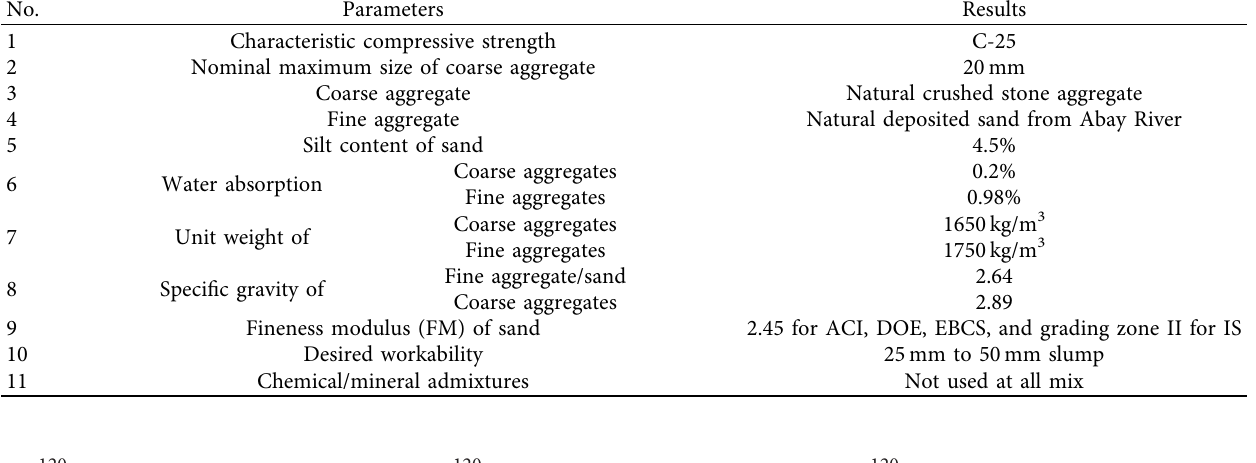
Table 4: Summary of aggregate physical proprieties.